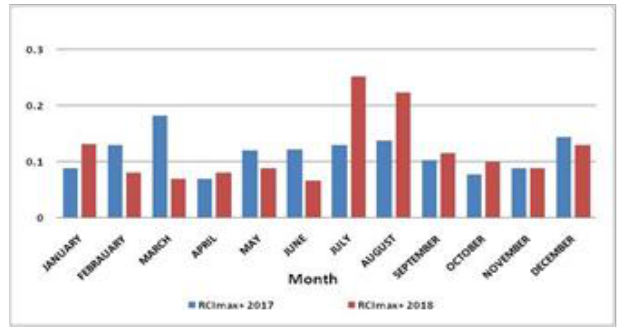
Figure 36. Comparison between RCI for ramping range of power ramps in 15 min interval for each month for years 2017 and 2018.